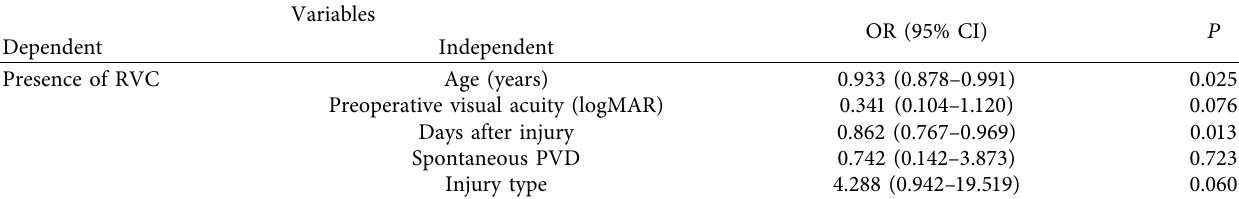
Table 2: Multivariate logistic regression analysis of factors independently contributing to presence of RVC.